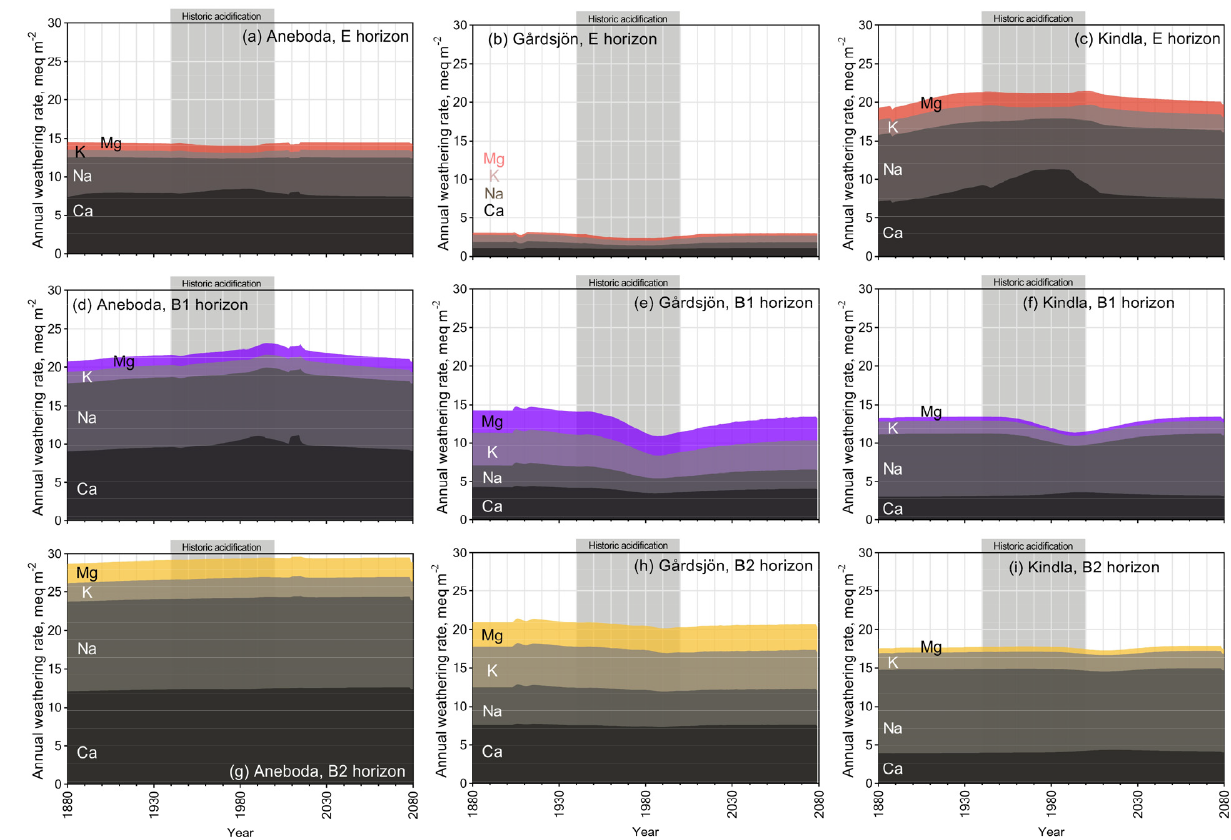
Figure 4. Stack plot of simulated base cation weathering rates in the NH scenario, with subdivisions of elemental components.